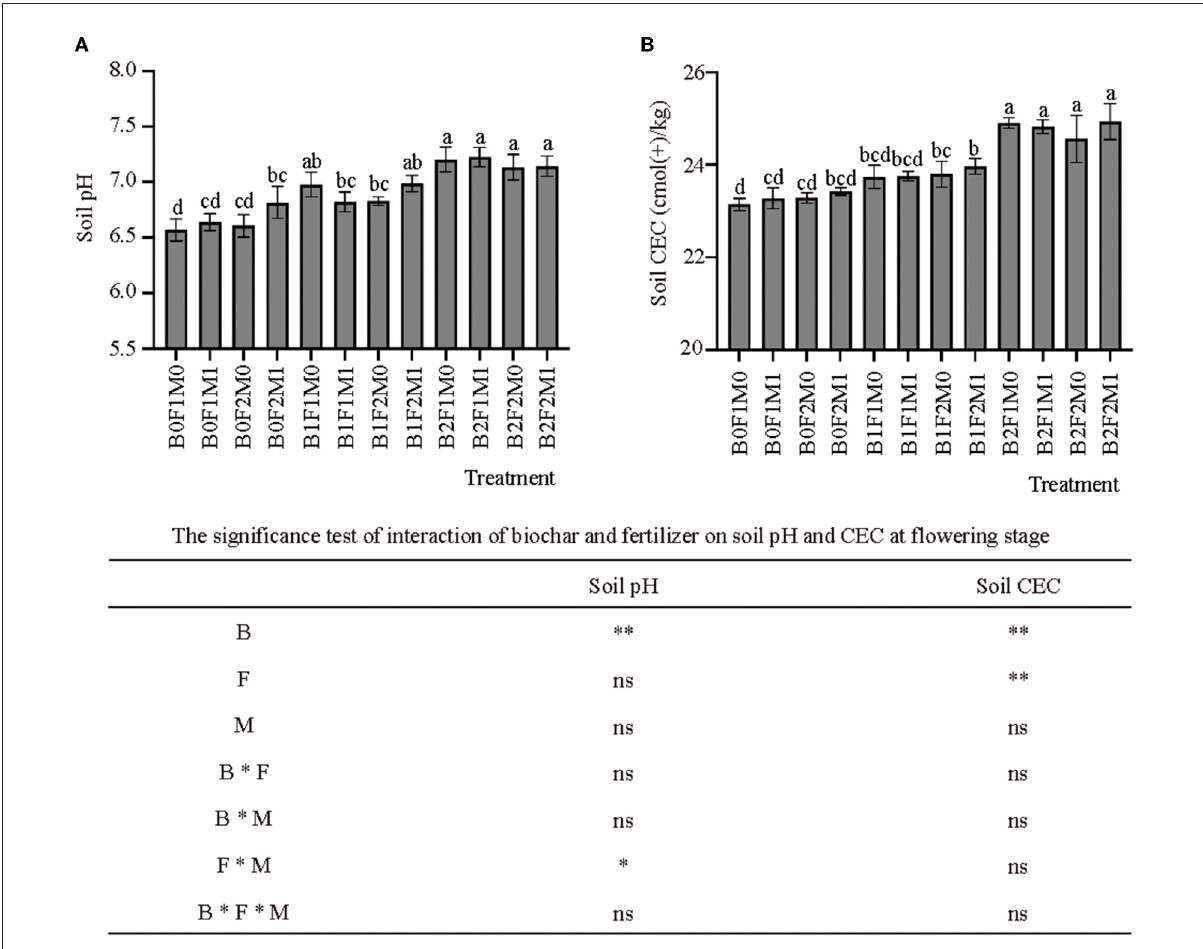
FIGURE2 Effects of biochar, inorganic fertilizer and organic fertilizer on soil pH (A) and CEC (B) at flowering stage. Bars followed by the same letter are not significantly different according to LSD-test ( P ≤ 0.05). Bars represent standard errors of the means. * and ** Significant difference at p = 0.05 and p = 0.01, respectively, and ns indicates no significant